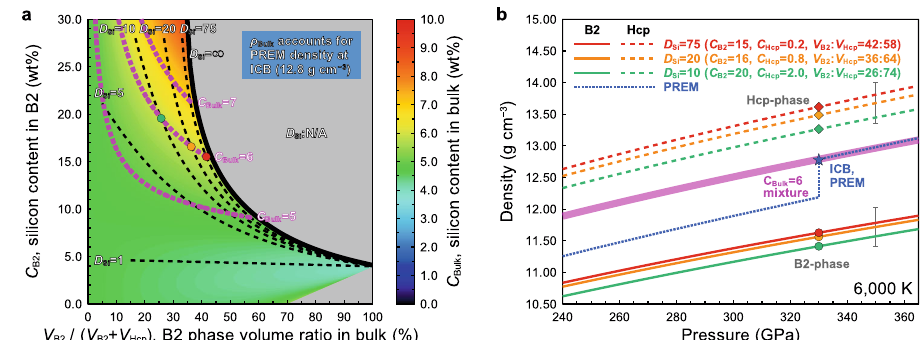
Fig. 5 Silicon content, volume ratio, and pressure – density relationship of two-phase mixtures of B2 and hcp phases to account for the PREM density. a Reasonable silicon content in the bulk composition of the two-phase mixture of B2 and hcp phases to account for the density of the PREM at the ICB condition of 12.8 g cm − 3 . Horizontal and vertical axes represent the volume ratio of the B2 phase and the silicon content of the B2 phase ( C B2 ), respectively. Silicon content of the hcp phase ( C Hcp ) (not described in this fi gure) is constrained by the PREM density with Eqs. (6) ‒ (8). C Bulk values are >4 wt% as shown in the colour contour (silicon contents of <4 wt% are not available, which are shown by black, blue, and cyan colours). The C B2 and volume ratio of B2 phase in the grey areas cannot reproduce the density of the PREM inner core. Variations of D Si (i.e., C B2 / C Hcp ) of 1, 5, 10, 20, and 75 are shown as black dashed curves. D Si of ∞ (which means C Hcp is almost 0 wt%) is shown as a black bold curve. The curves of D Si = 75 and ∞ are close, which indicates that the compositions and volume faction of the two-phase pairs for D Si = 75 and ∞ are almost the same. Typical C bulk of 5, 6, and 7 wt% are shown as magenta dotted lines. Colour circles represent typical conditions of C Bulk = 6 with D Si = 75 (red), D Si = 20 (orange), and D Si = 10 (green). b Pressure – density relations at C Bulk = 6 and B2 and hcp phases at 6000 K. C B2 and C hcp and volume percent ratios of V B2 and V hcp corresponding to the conditions in Fig. 5a are shown. Grey bars represent 1 σ error of the EoS. The discontinuity of the blue dotted line represents the boundary of the liquid outer core and the solid inner core of PREM. Blue star represents the inner core of PREM at ICB. Coloured diamonds with dashed curves represent the density of the hcp phase at ICB and density curve at high pressure and 6000 K. Coloured circles are of the B2 phase. Pairs of the same colour symbols can account for the PREM density at ICB (a blue star). Magenta line represents the combined EoS of the two-phase mixture of the B2 and hcp phases. The density curves of the three models of the two-phase mixtures are within the width of the line.